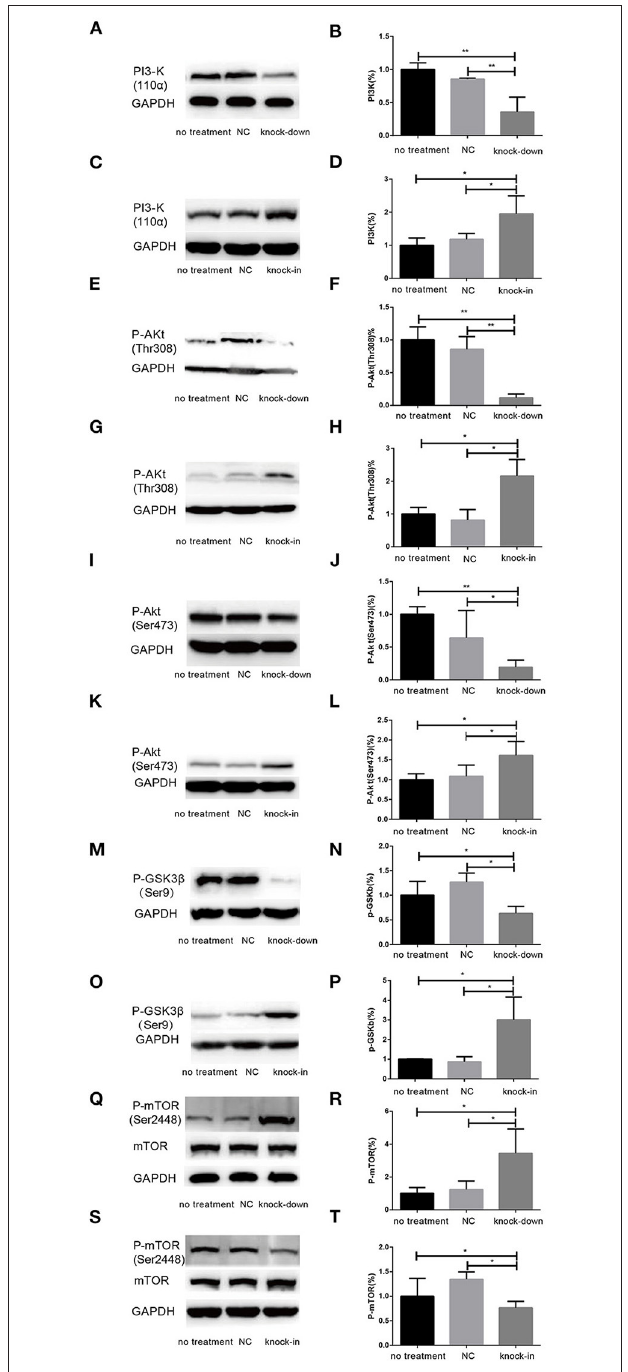
FIGURE 6 | DHCR24 knock-down induced the overactivation of GSK3 β /mTOR signaling via PI3K/Akt pathway. (A,B,E,F,I,J,M,N,Q,R) Representative western blots of total PI3-K, p-Akt at Ser473, p-Akt at Thr308, p-GSK3 β at Ser9, total mTOR, p-mTOR at Ser2448 from DHCR24 knock-down SH-SY5Y cells. (C,D,G,H,K,L,O,P,S,T) Representative western blots of total PI3-K, p-Akt at Ser473, p-Akt at Thr308, p-GSK3 β at Ser9, total mTOR, p-mTOR at Ser2448 from DHCR24 knock-in SH-SY5Y cells. All the